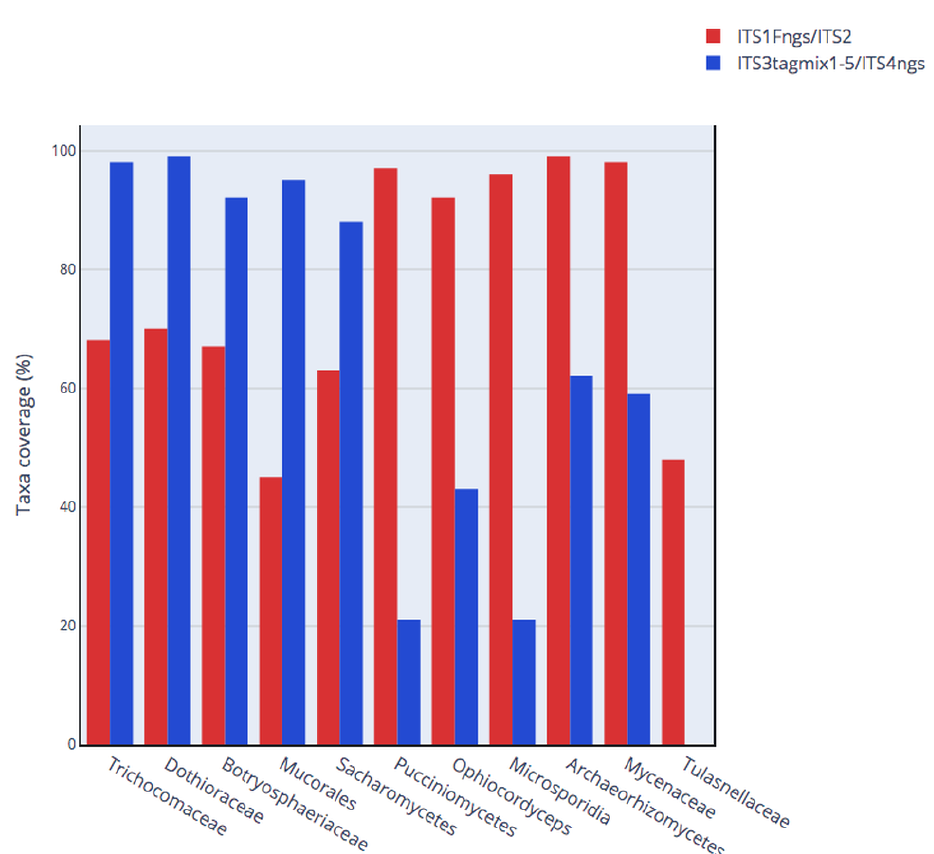
Figure 3. Percentage of sequences amplified (fungal taxa covered) from the UNITE database using two different pairs of primers targeting ITS1 (red) and ITS2 (blue). A maximum of three mismatches was allowed for the in silico amplification.